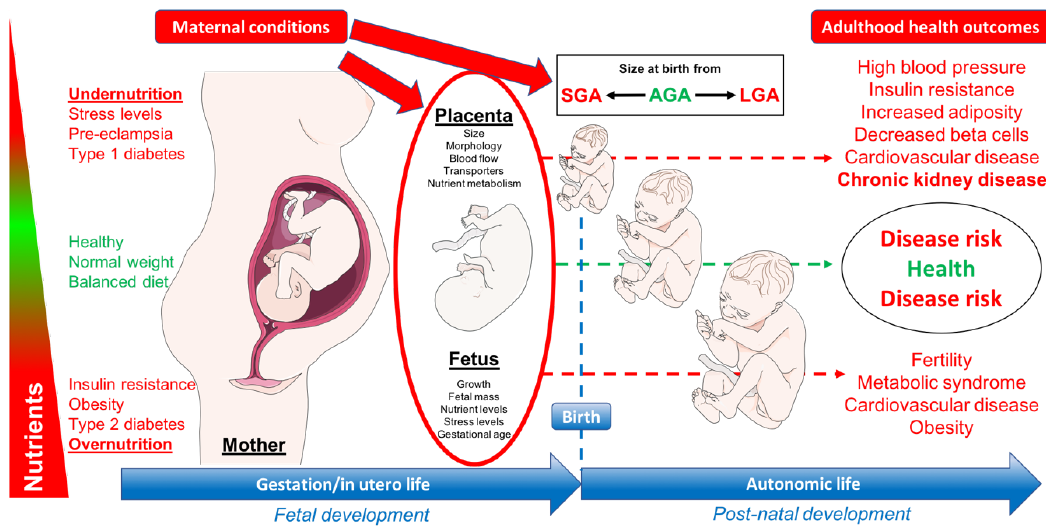
Figure 1. Effect of maternal diet during pregnancy on offspring. Adapted from Chavatte-Palmer P, Tarrade A, Rousseau-Ralliard D: Diet Before and During Pregnancy and Offspring Health: The Importance of Animal Models and What Can Be Learned from Them. International Journal of Environmental Research and Public Health 2016, 13. SGA: small for gestational age; AGA: adequate for gestational age; LGA: large for gestational age.